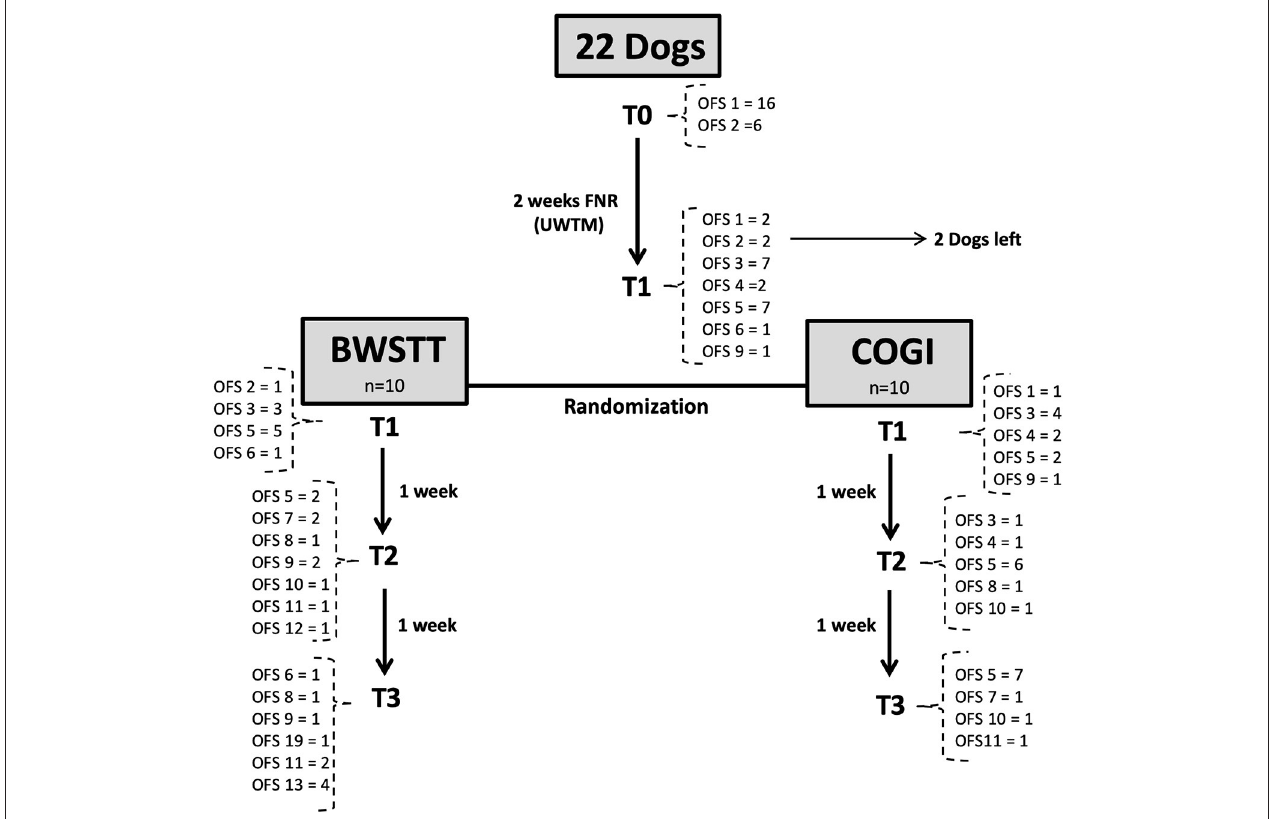
FIGURE 9 | Flow diagram describing the neurologic evolution of the 22 dogs. FNR, Functional neurorehabilitation; UWTM, Underwater treadmill; T0, Admission; T1, After 2 weeks, randomization time; T2: After 1 week of specific protocol; T3, After 2 weeks of specific protocol; BWSTT, Body-weight supported treadmill training; COGI, conventional overground